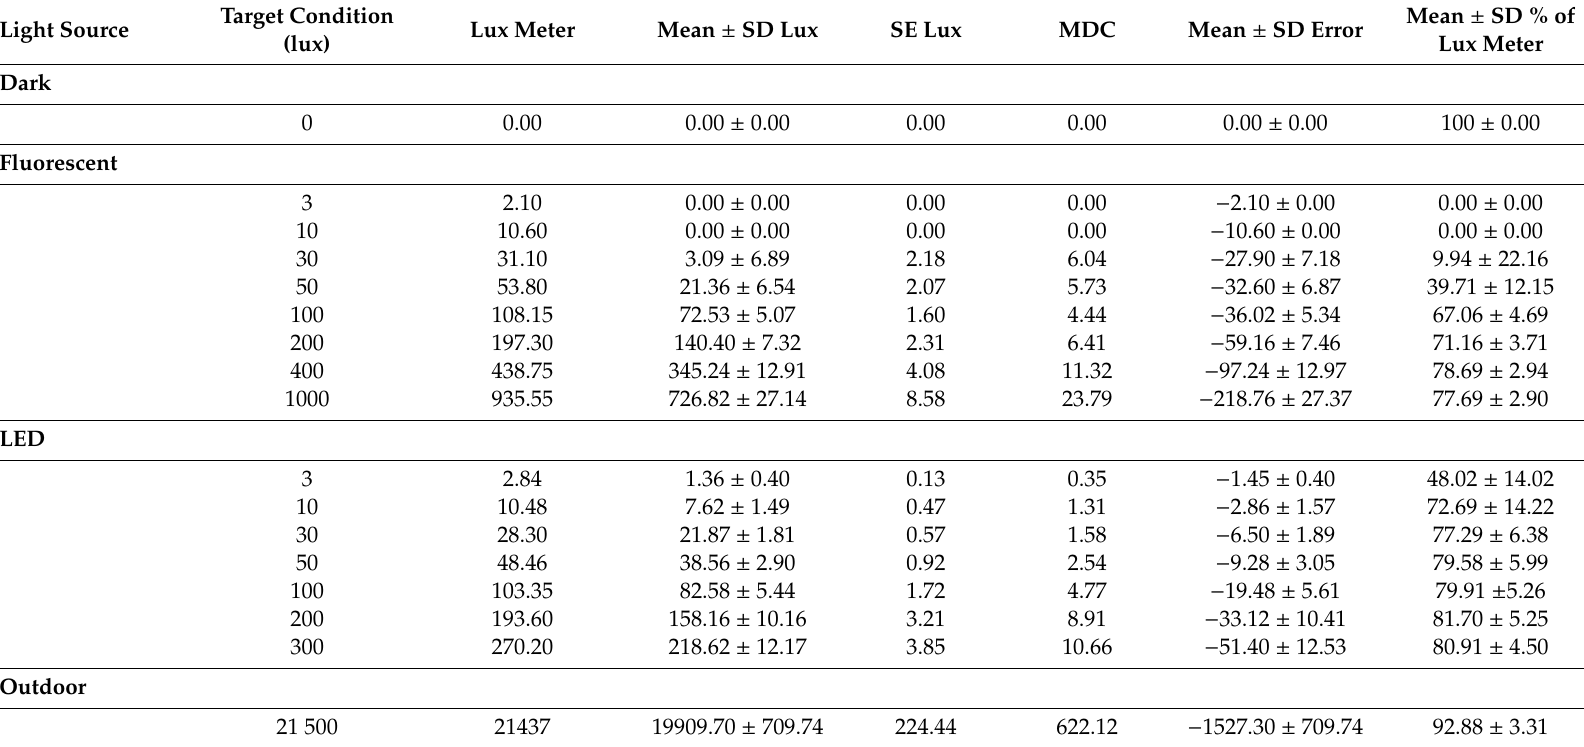
Table 2. Summary statistics across n = 10 GENEActiv devices under broad-spectrum white fluorescent and LED light sources. Light